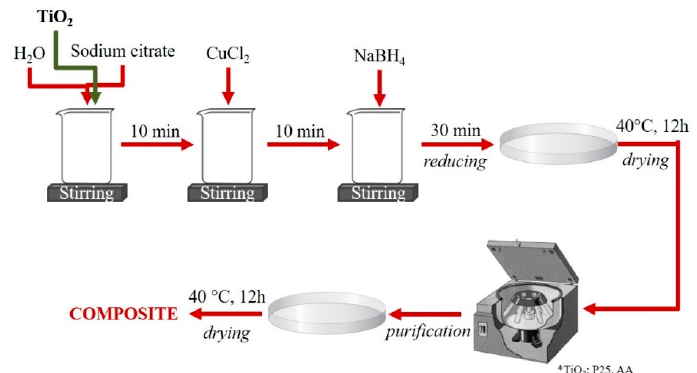
Figure 1. The main steps of the synthesis of the composites containing TiO 2 and Cu nanoparticles—the nanoparticles were obtained from CuCl 2 by chemical reduction with NaBH 4 , and the TiO 2 was purchased commercially (AA and